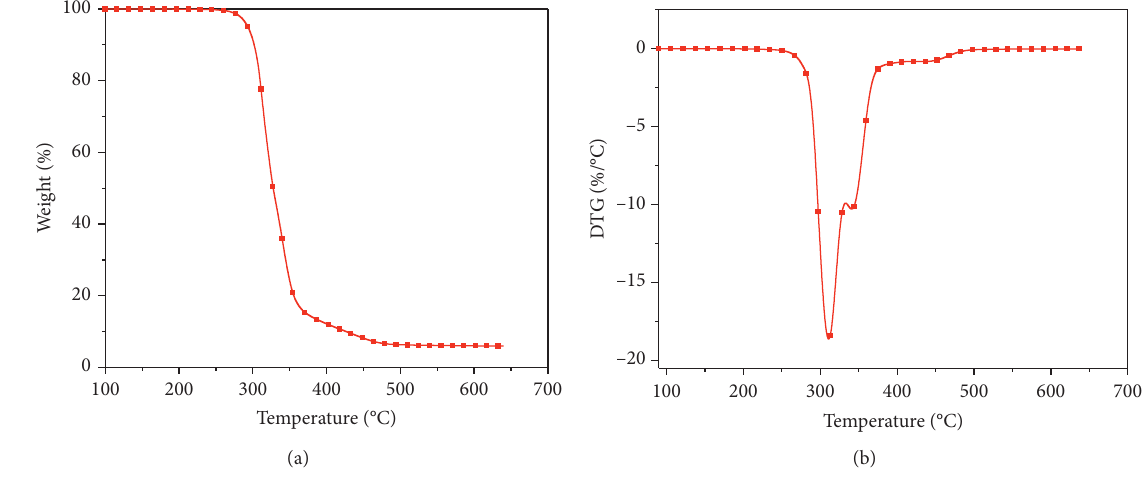
Figure 4: TGA (a) and DTG (b) curves of Table 1: Proportion and the flame retardant property of the samples.